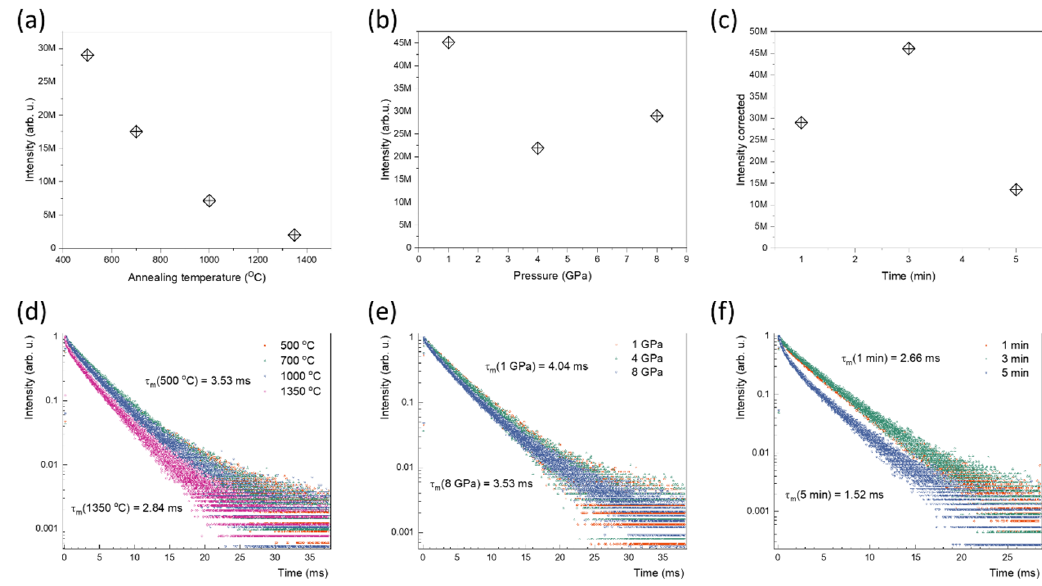
Figure 7. The luminescence intensity of BMW:Eu-CT ( a ), BMW:Eu-CP ( b ), and BMW:Eu-CTS ( c ) ceramic material series and the luminescence decay curves of BMW:Eu-CT ( d ), BMW:Eu-CP ( e ), and BMW:Eu-CTS ( f ).